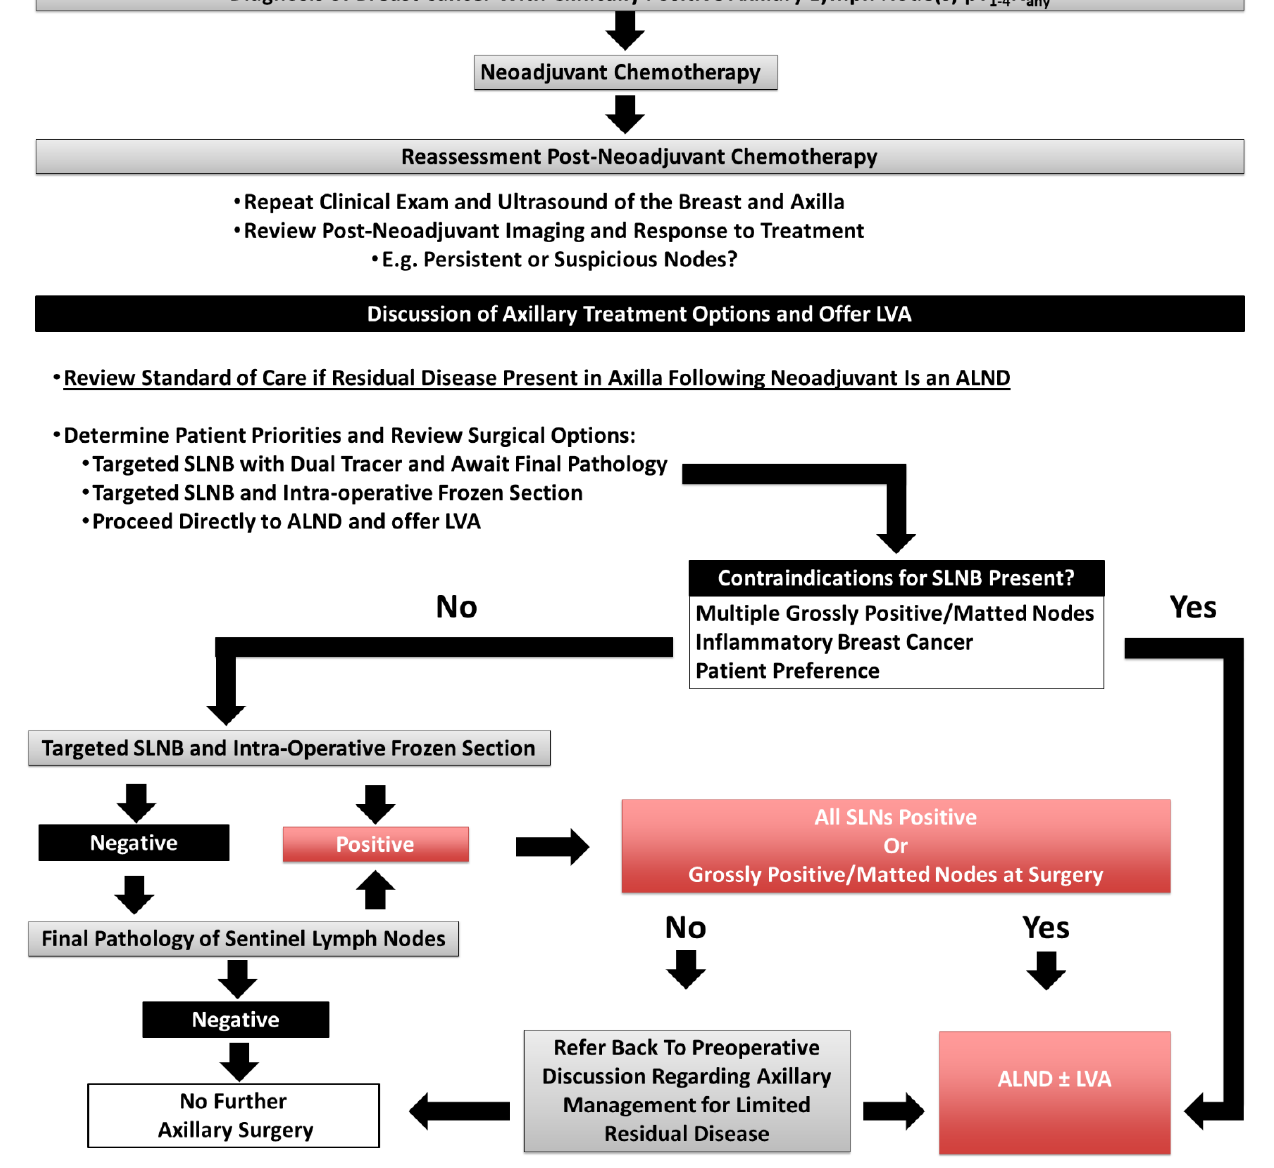
Figure 2. Proposed Patient Care Pathway for Patients with Clinically Positive Nodal Disease Who Received Neoadjuvant Chemotherapy. ALND: Axillary Lymph Node Dissection. LVA: Lymphovenous Anastomosis. SLNB: Sentinel Lymph Node Biopsy.